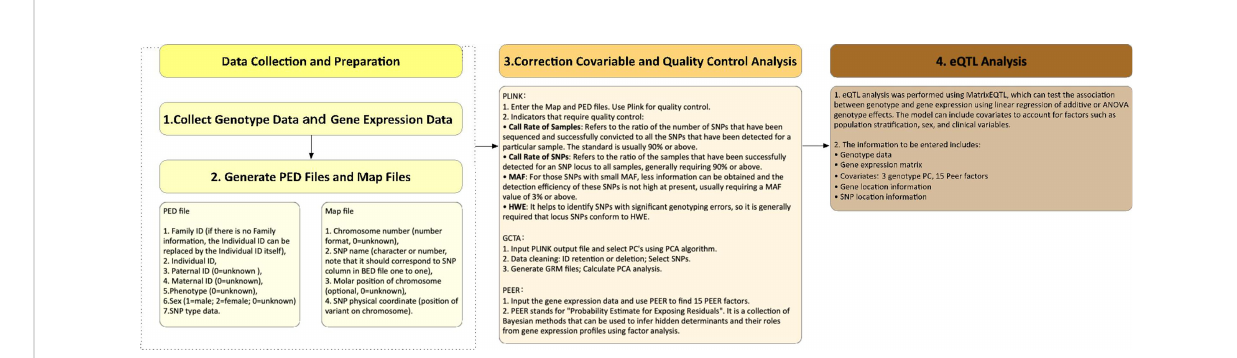
FIGURE 1 The fl ow diagram of common eQTL analysis processes. The eQTL data we analyzed were also generated by these